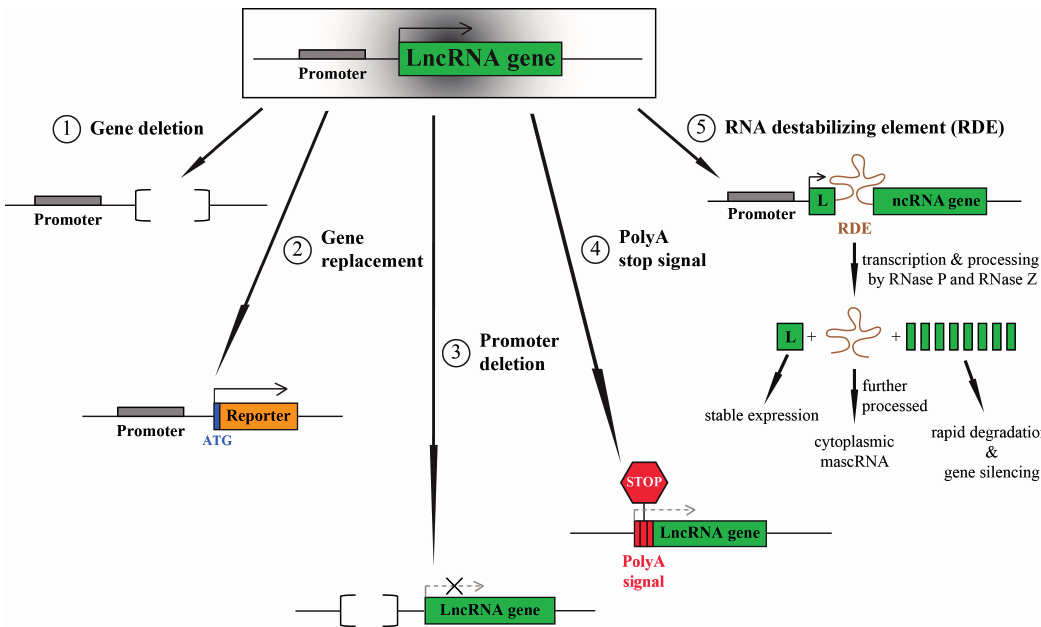
Figure 1. Long non-protein-coding RNA (LncRNA) targeting strategies for in vivo loss-of-function